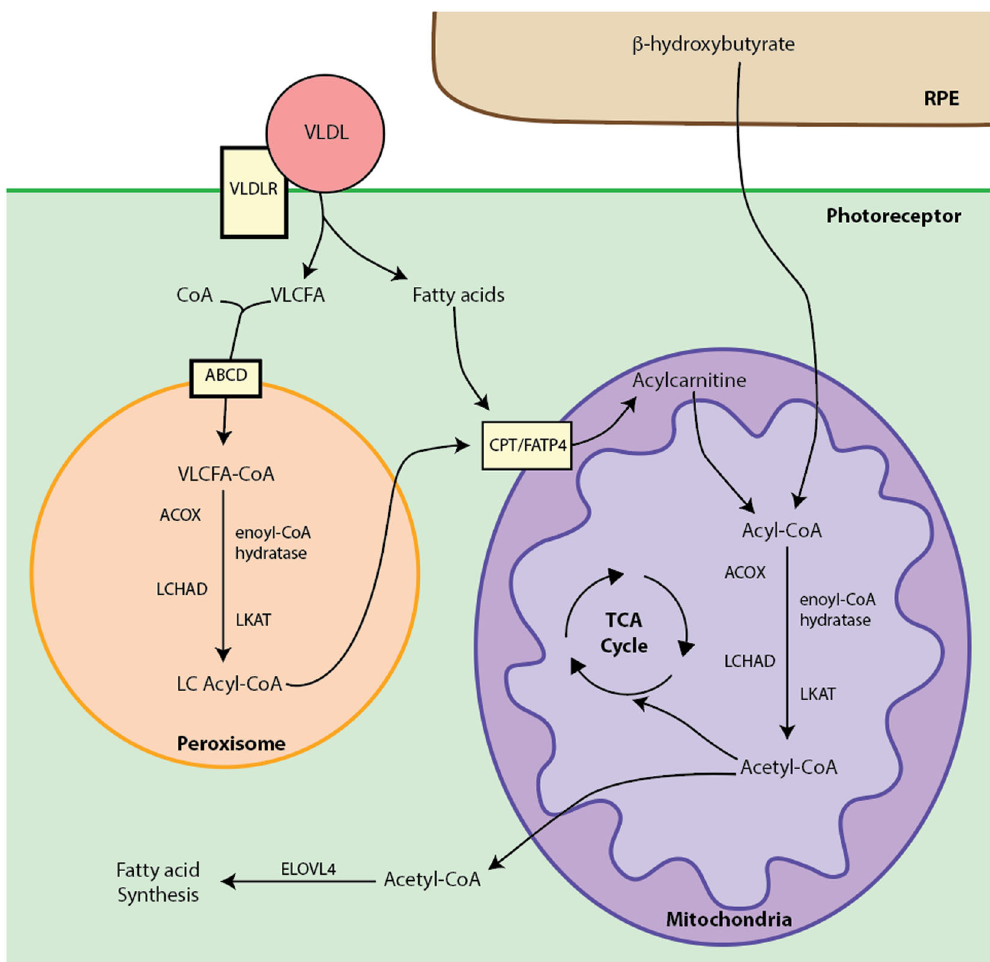
Fig. 5 Fatty acid oxidation. The VLDLR (very low-density lipoprotein receptor) on photoreceptors facilitates binding of VLDLs (very low-density lipoproteins) and in fl ux of VLCFAs (very long chain fatty acids; >22 carbons). VLCFAs join with CoA (coenzyme A) and enter peroxisomes where they undergo fatty acid β -oxidation (FAO) via acyl-CoA oxidase (ACOX), enoyl-CoA hydratase, LCHAD (long chain L3 hydroxyacyl-CoA dehydrogenase),